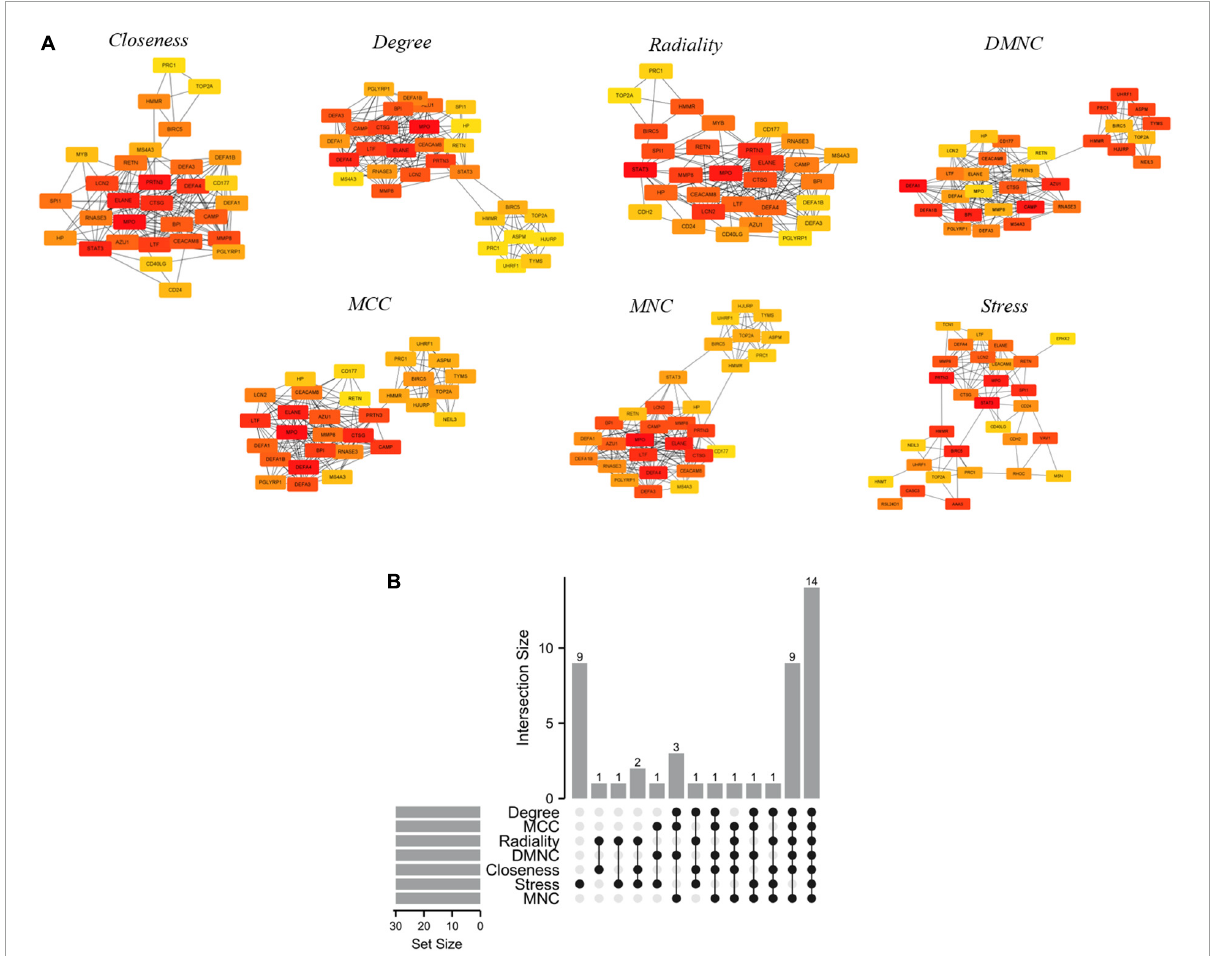
FIGURE5 Hub genes identified by different algorithms and UpSet diagram. (A) Hub gene identified by seven different algorithms (Degree, MNC, DMNC, MCC, Closeness, Radiality, and Stress) using Cytohubba. Node color reflects the degree of connectivity. Red represents a higher degree, and yellow represents a lower degree. (B) The UpSet diagram showed that the seven algorithms screened 14 overlapping hub